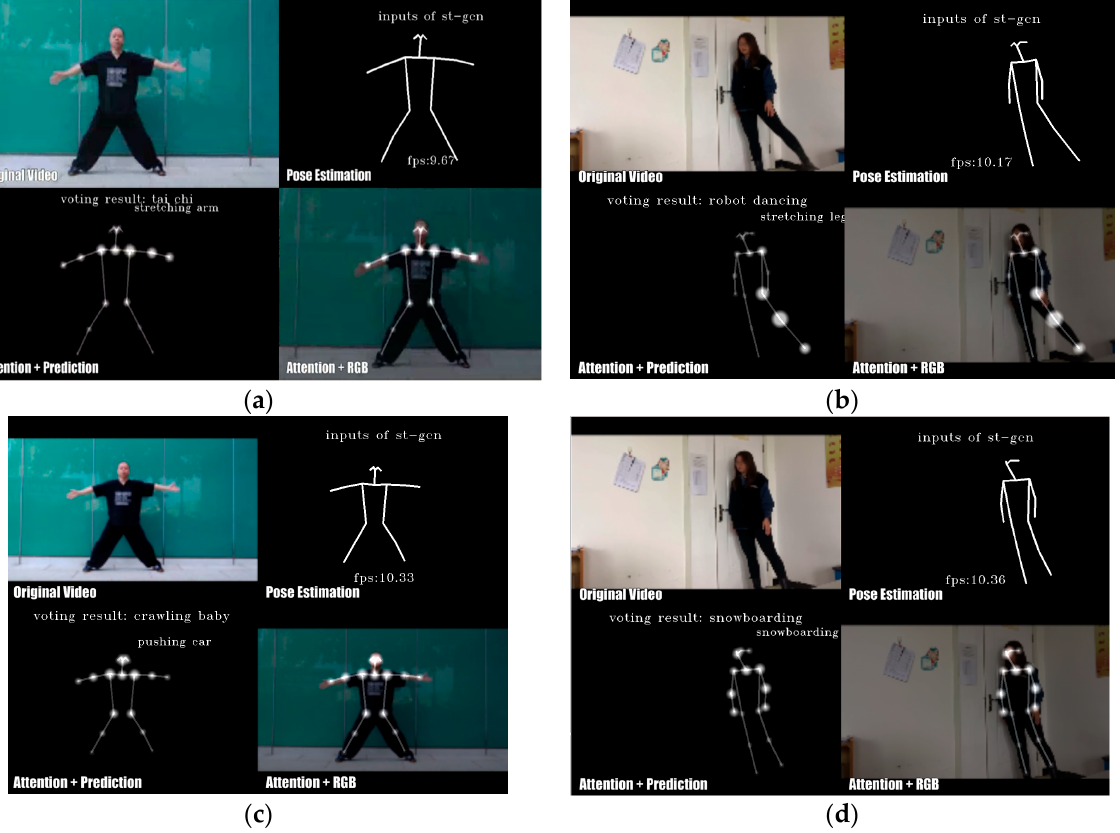
Figure 8. Comparison of NEW-STGCN-CA and two-stream identification. Figures ( a , c ) show NEW-STGCN-CA and Two-Stream recognizing the stretching arm action in Tai Chi, and Figures ( b , d ) show NEW-STGCN-CA and Two-Stream recognizing the stretching leg action, respectively. In practical applications,